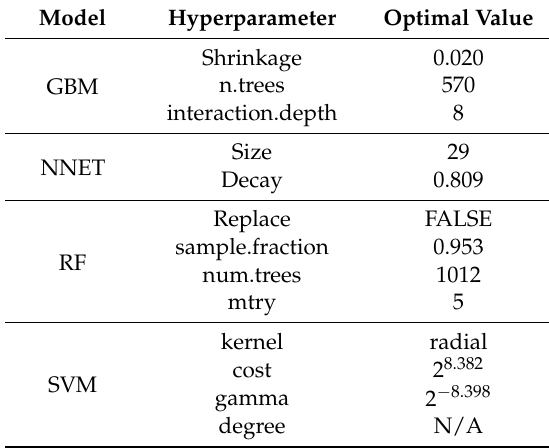
Table 7. The optimum parameters obtained by the tuning process.